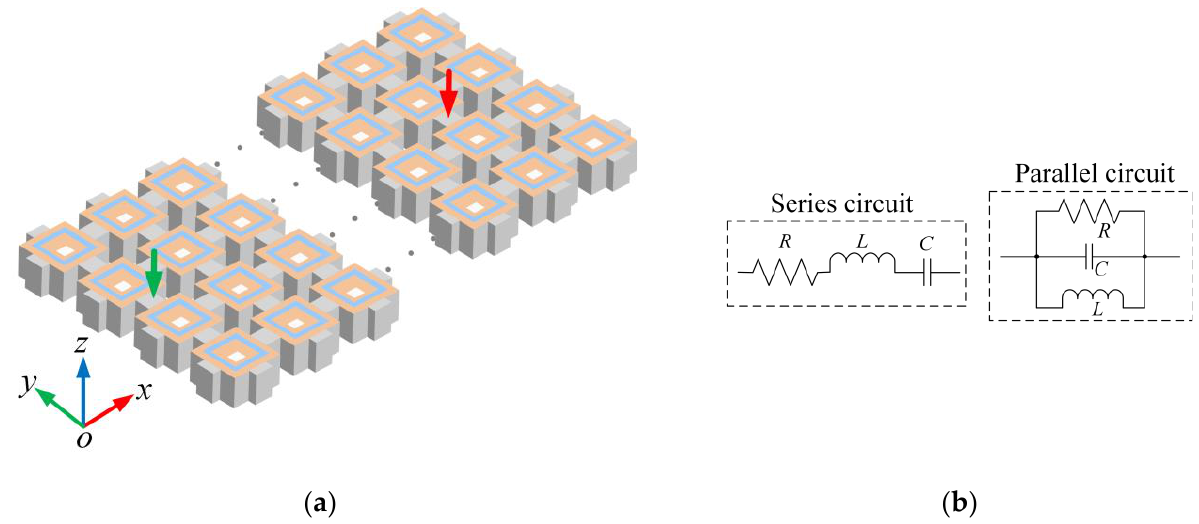
Figure 8. ( a ) Finite length piezoelectric phononic crystal; ( b ) The employed external circuit.